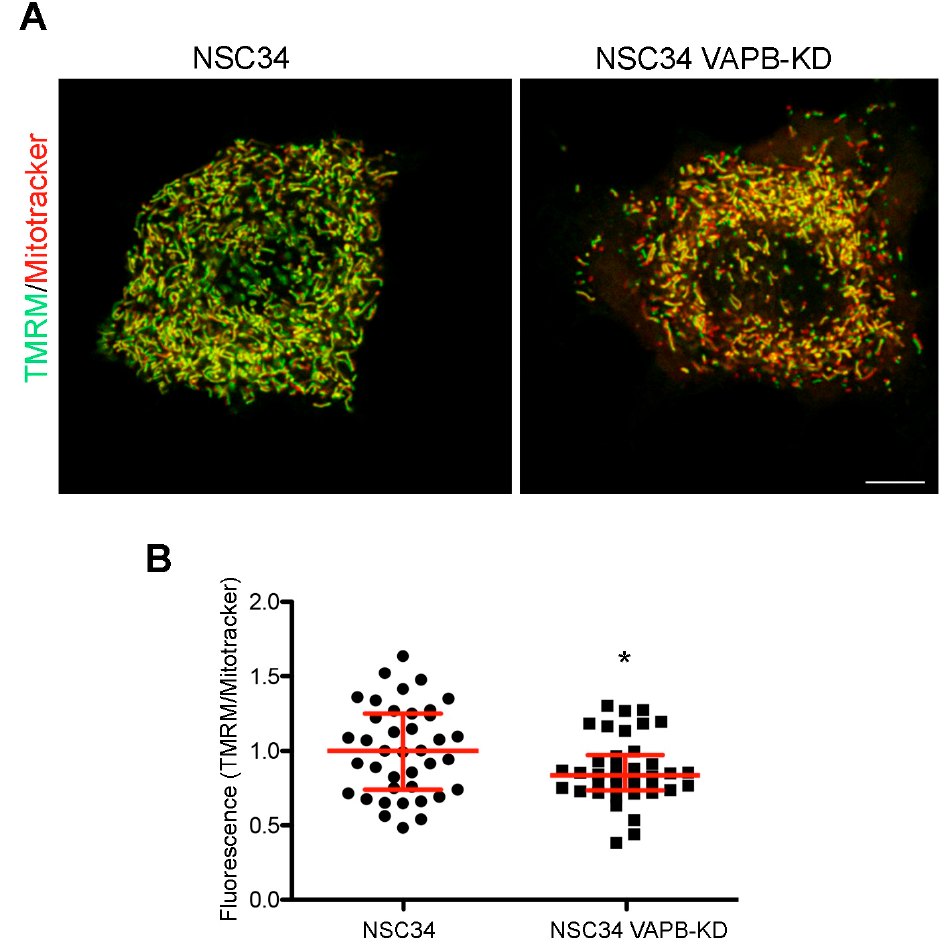
Figure 2. VAPB knockdown decrease mitochondrial membrane potential in the MN-like cell line NSC34. ( A ) Representative images comparing staining with the membrane potential-sensitive and insensitive mitochondrial dyes TMRM (green) and Mitotracker (red), respectively, in control or VAPB-silenced cells (details on the cell lines are in [94]). NSC34 cells were incubated for 30 min with TMRM and Deep Red-Mitotracker (both fromThermoFisher), each at 100 nM concentration, and then imaged alive, using the LSM800 confocal system equipped with an on-stage incubator (37 ◦ C, 5% CO 2 ) and a PlanApo 63 × 1.4 N.A. objective. The lack of bleedthrough between the red and far red signals was checked in singly labelled specimens. The images show single confocal sections, with the merged signal from the two channels. The prevalence of the green pseudocolour in the image of the control versus the silenced cells indicates a higher TMRM to Mitotracker ratio. Acquisition parameters and subsequent adjustment with Adobe Photoshop software were kept identical for the two illustrated images. Scale bar, 10 µ M. ( B ) Quantification of TMRM to Mitotracker fluorescence in control and VAPB-silenced cells. The analysis was carried out on stacks of 5–7 sections of cells, imaged as in panel ( A ), keeping the illumination conditions so as to avoid any saturation of the signal. A mask of the Mitotracker signal was created using ImageJ software, and the integrated intensity of the Mitotracker and TMRM signals determined within the mask on each section, and then summed over the entire stack. The ratios of the summed integrated intensities for each individual stack (acquired in seven independent experiments), together with the medians and interquartile range are shown. * p = 0.025 by Student’s two-tailed t